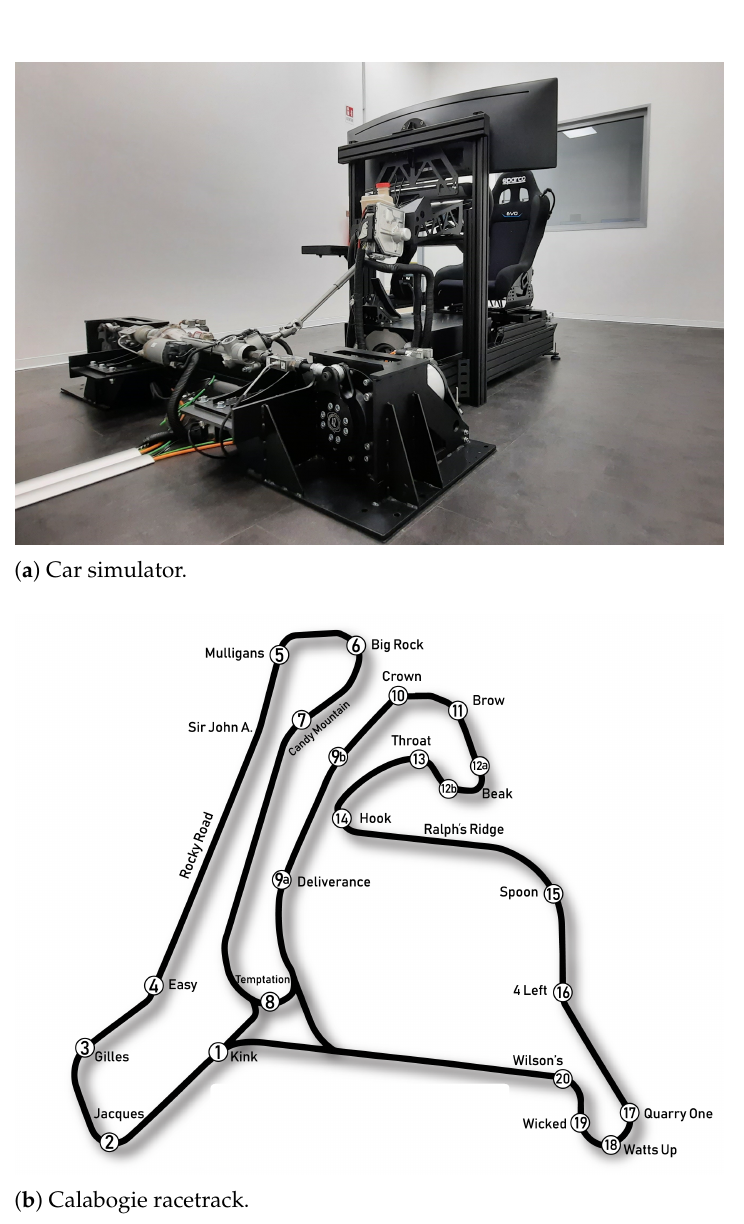
Figure 6. Tests set-up.